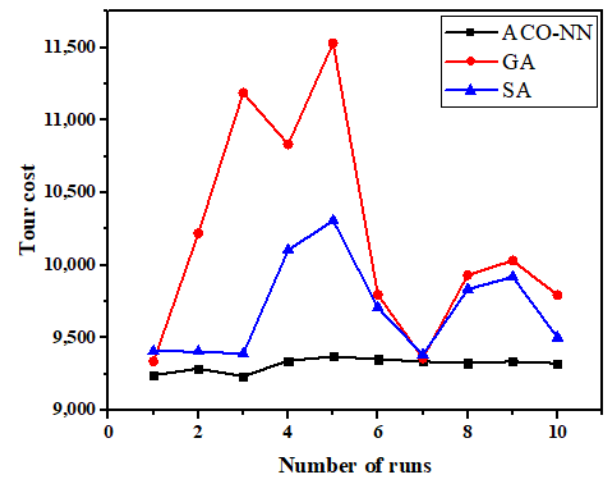
Figure 2. Comparison of ACO-NN to GA and SA for Bayg29.